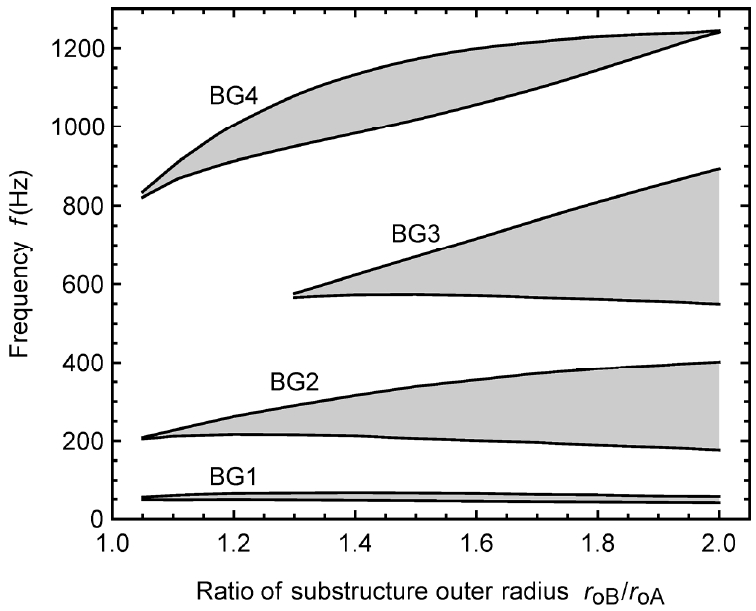
Figure 4. BGs as function of the ratio of substructure outer radius.